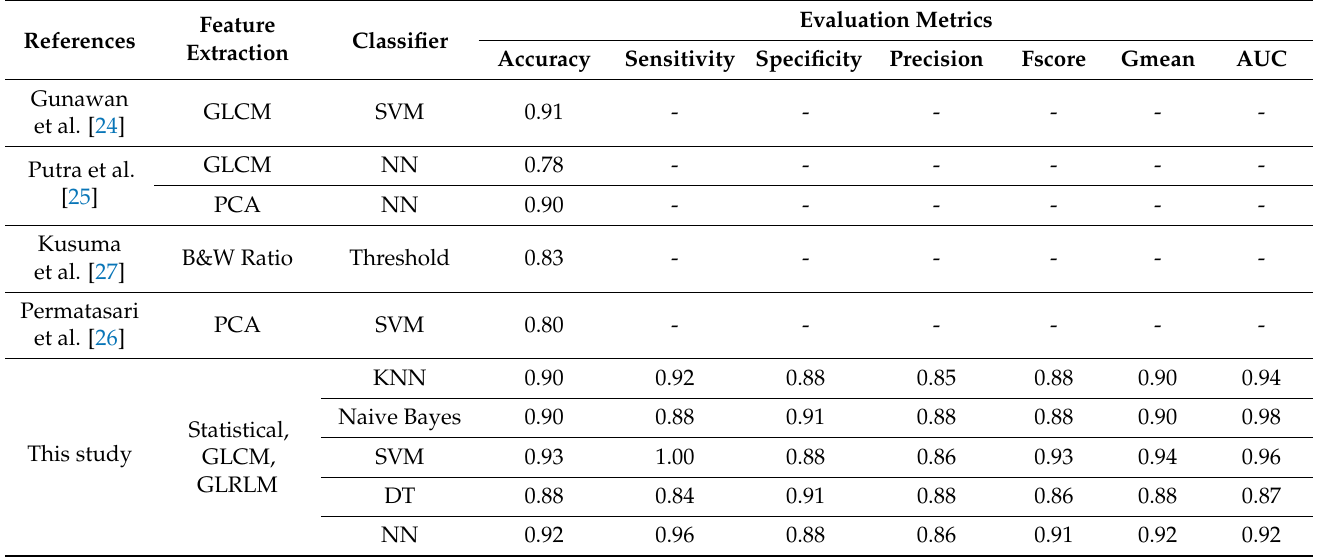
Table 10. Comparison to existing